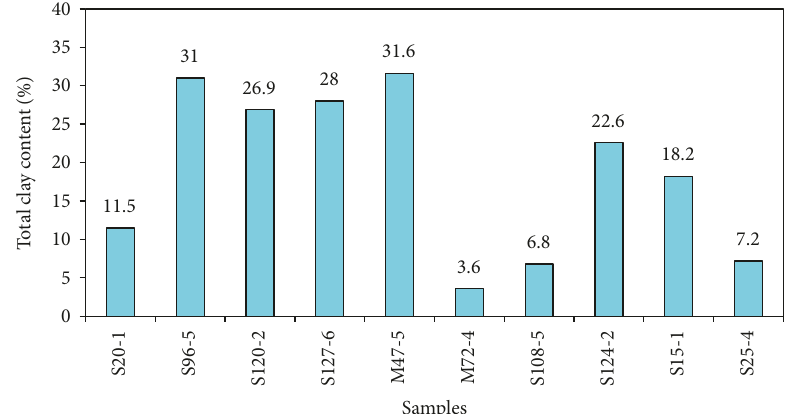
Figure 4: Samples ’ total clay content.